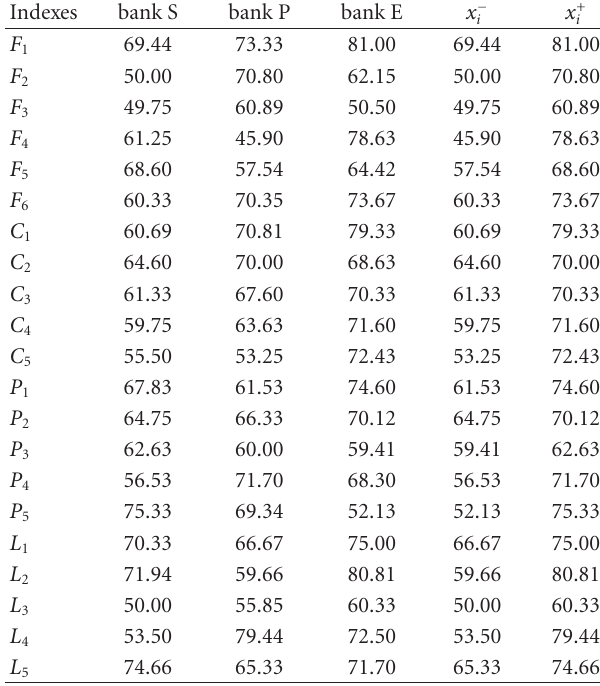
Table 6: The performance matrix with the best value x + j and worst value x − j by VIKOR.